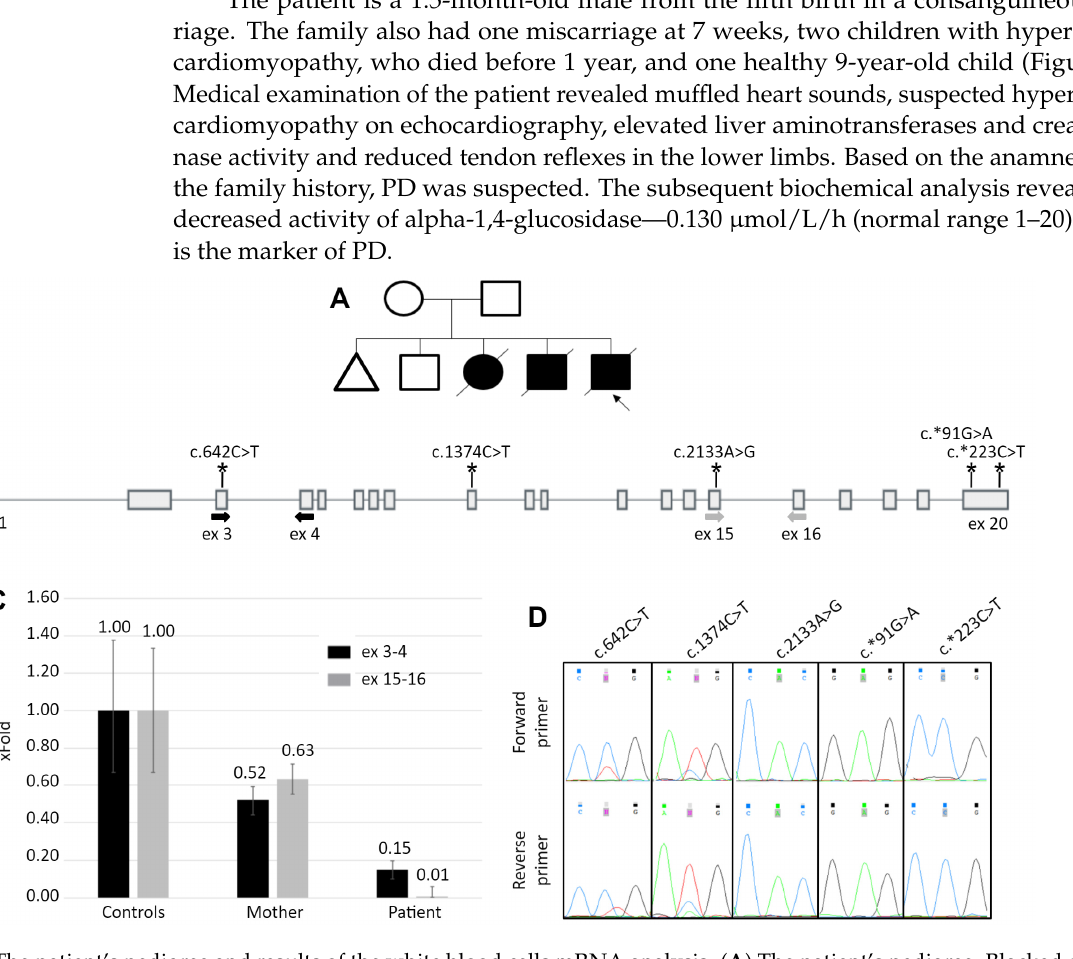
Figure 1. The patient’s pedigree and results of the white blood cells mRNA analysis. ( A ) The patient’s pedigree. Blacked out symbol—patient with the PD phenotype; crossed out—deceased patient; triangle—miscarriage. ( B ) The scheme of the GAA gene. Bold arrows indicate location of the primers for qPCR and asterisks indicate the location of heterozygous var- iants, identified in the mother’s DNA. ( C ) The results of qPCR for the GAA cDNA with primers spanning exons 3–4 and 15–16. Controls—mean and standard deviation for 5 healthy control samples. For the mother’s and the patient’s samples the standard deviation was calculated from technical replicates. ( D ) Sanger chromatograms of the mother’s cDNA frag- ments containing heterozygous variants. The allelic imbalance demonstrates the similar to the qPCR data, expression pat- tern.